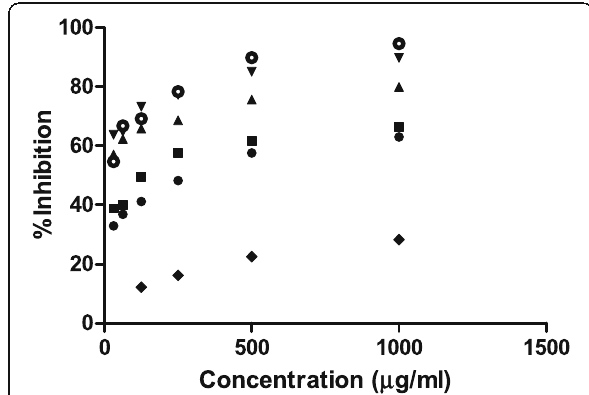
Fig. 1 DPPH Free Radical Scavenging Activity at Different Concentration of Methanol Extract and its Fractions. The IC 50 values of Methanol Extract and its Hexane, EoAC, BuOH, R. aqueous Fractions are 0.3302 mg/ml, 0.1527 mg/ml, 0.2691 mg/ml, 0.2517 mg/ml, 0.585 mg/ml and 0.1927 mg/ml, respectively. Legends: MeOH, Hexane, EoAC,